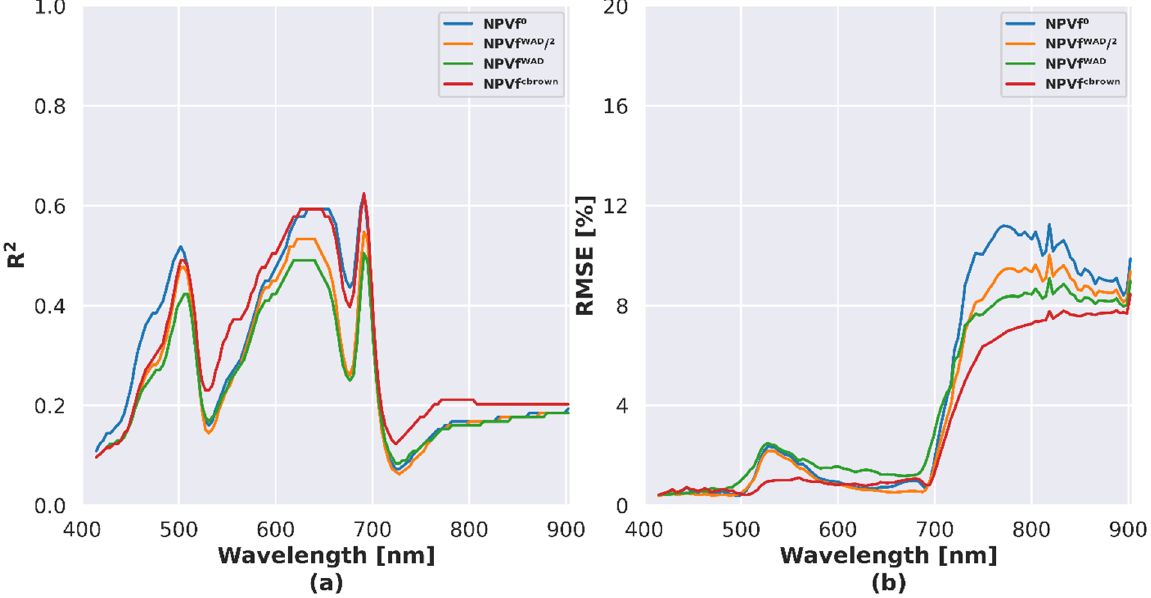
Figure 8. Spectral variation of ( a ) R 2 and ( b ) root mean square error ( RMSE ) for the different scenarios accounting for NPVf , and accounting for pixel-specific leaf optical properties.